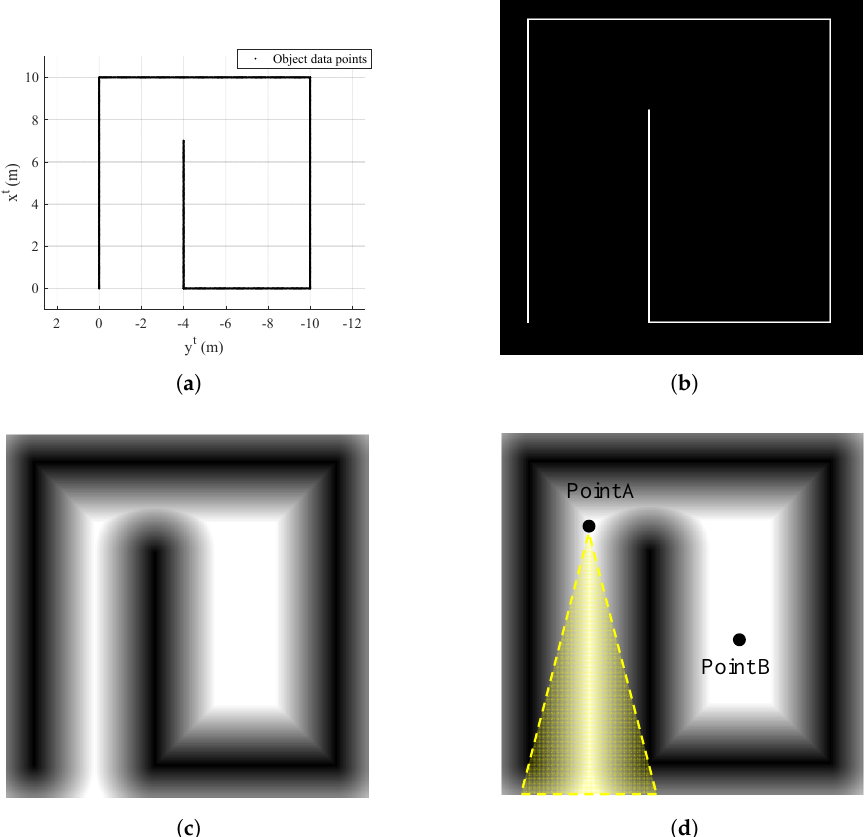
Figure 4. Image processing for exploration completion logic: ( a ) obtained object data points (top view, tangent–plane coordinate system); ( b ) binary image; ( c ) distance transform; and ( d ) two different UAV